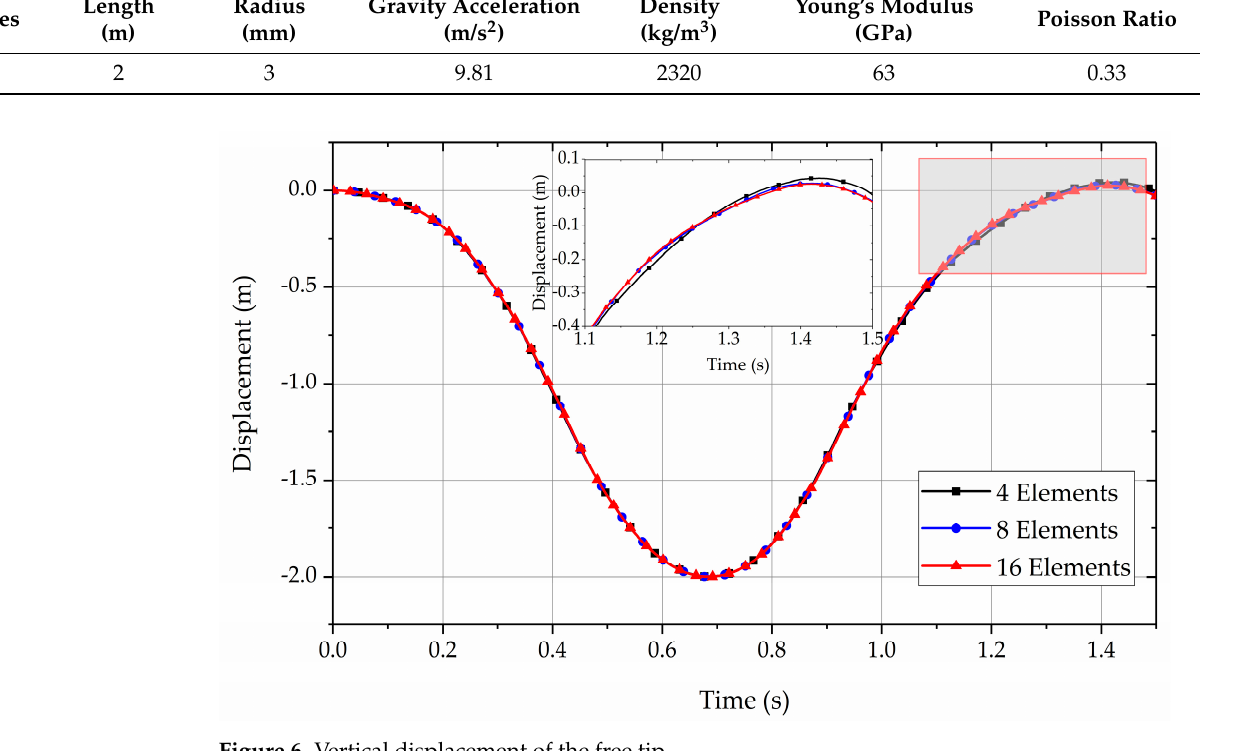
Figure 6. Vertical displacement of the free tip.